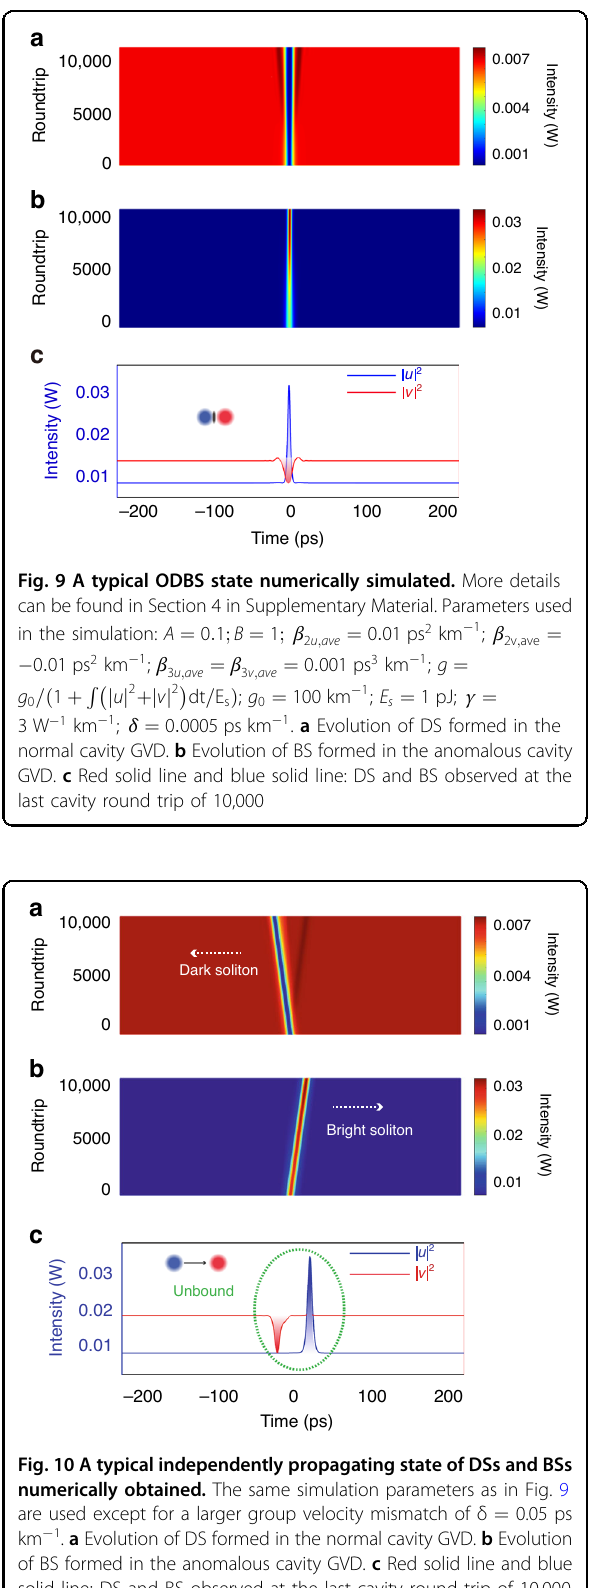
Fig. 10 A typical independently propagating state of DSs and BSs numerically obtained. The same simulation parameters as in Fig. 9 are used except for a larger group velocity mismatch of δ = 0.05 ps km − 1 . a Evolution of DS formed in the normal cavity GVD. b Evolution of BS formed in the anomalous cavity GVD. c Red solid line and blue solid line: DS and BS observed at the last cavity round trip of